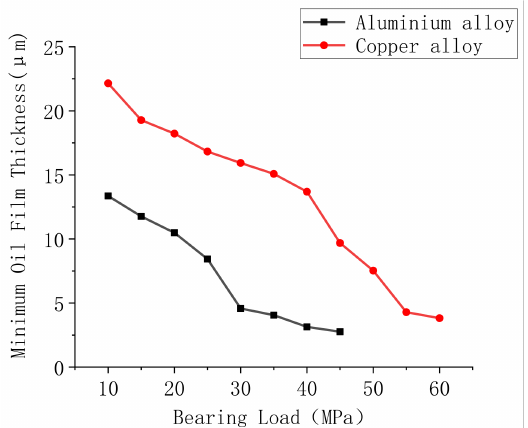
Figure 5. The minimum oil film thickness curves of the two